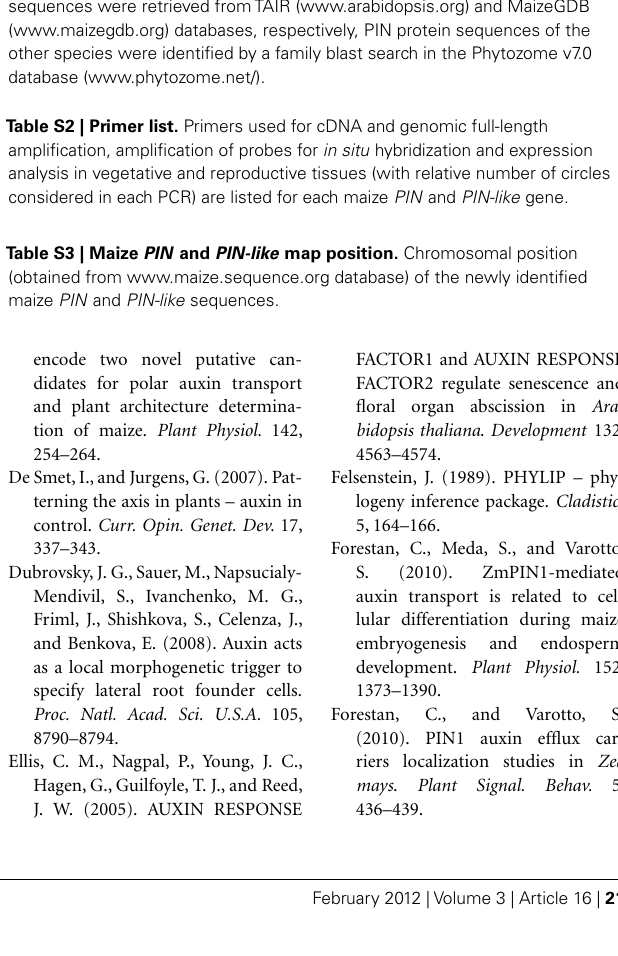
syntenic blocks have displayed with Synteny Mapping and Analysis Program (SyMAP) v3.4 (Soderlund et al., 2011; http://www.symapdb.org/). Figure S5 | Maize auxin transporter expression analysis from the Genome-wide atlas of transcription during maize development. ZmPINs , ZmPIN-like and BR2/ZmABCB1 expression levels analyzed in 60 distinct tissues representing 11 major organ systems of inbred line B73 (Sekhon et al., 2011). Expression graphs have been download from www.maizegdb.org: the green bars indicate tissues in which the gene is expressed. Figure S6 | In situ hybridization and anti-IAA negative controls. Specific sense RNA probes for each PIN genes were used as negative controls in every in situ hybridization experiment (A–D) while two different negative controls, no EDAC pre-fixation and without anti-IAA primary antibody were used. (A) Longitudinal section of a primary root hybridized with a ZmPIN1a sense probe. (B) Longitudinal section of a primary root apex hybridized with a ZmPIN1b sense probe. (C) Cross section of primary root hybridized with a ZmPIN9 sense probe. (D) Longitudinal section of a female inflorescences showing the mother cell of the megaspore inside the ovule hybridized with a ZmPIN1d sense probe. (E) Anti-IAA negative control on longitudinal section of a primary root not pre-fixed with EDAC. (F,G) Anti-IAA negative control on longitudinal sections of a primary root hybridized with the secondary antibody only. cc, central cylinder;